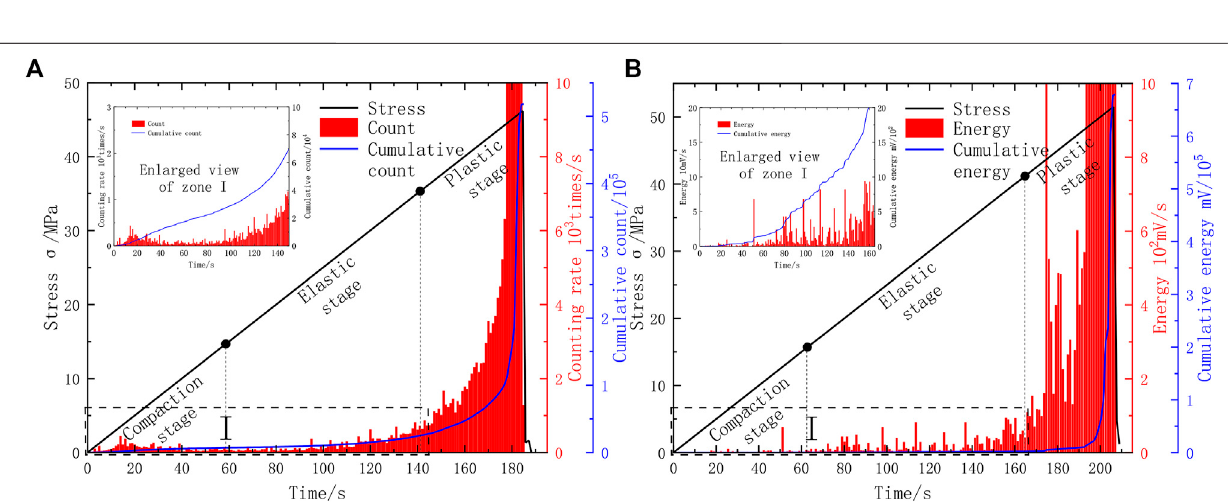
Frontiers in Earth Science |